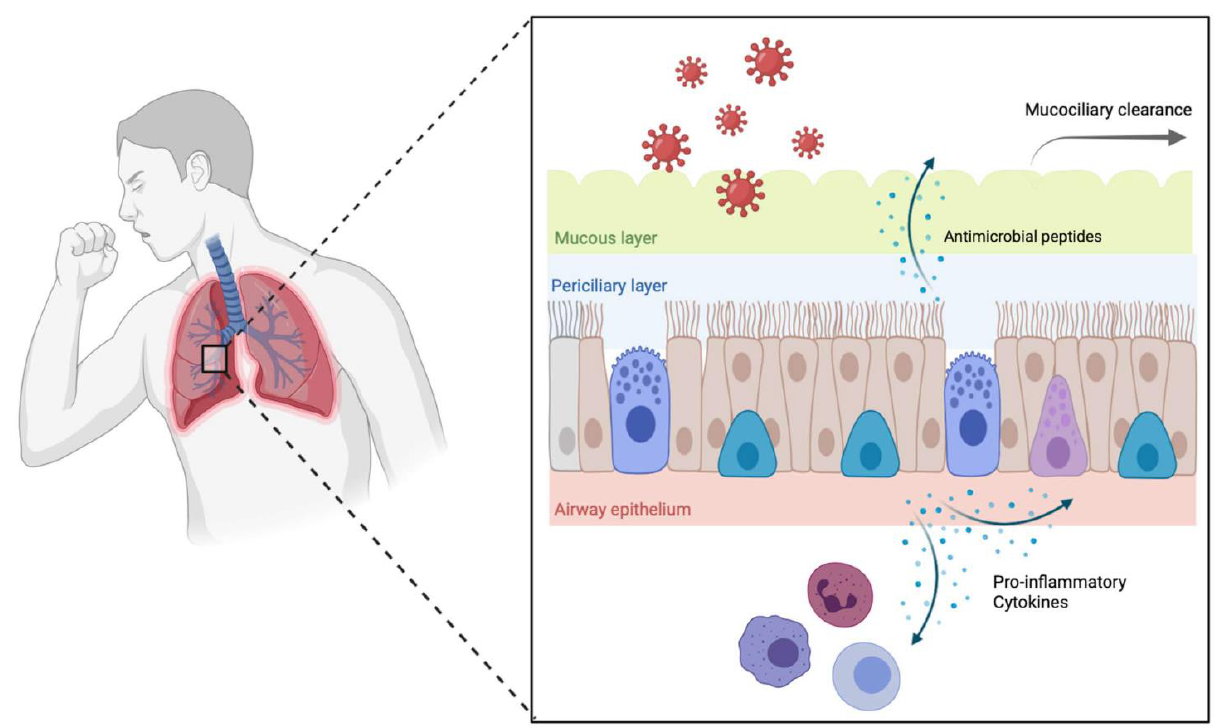
Figure 1. Barrier function, mucociliary clearance, and host defenses in the normal airway epithe-